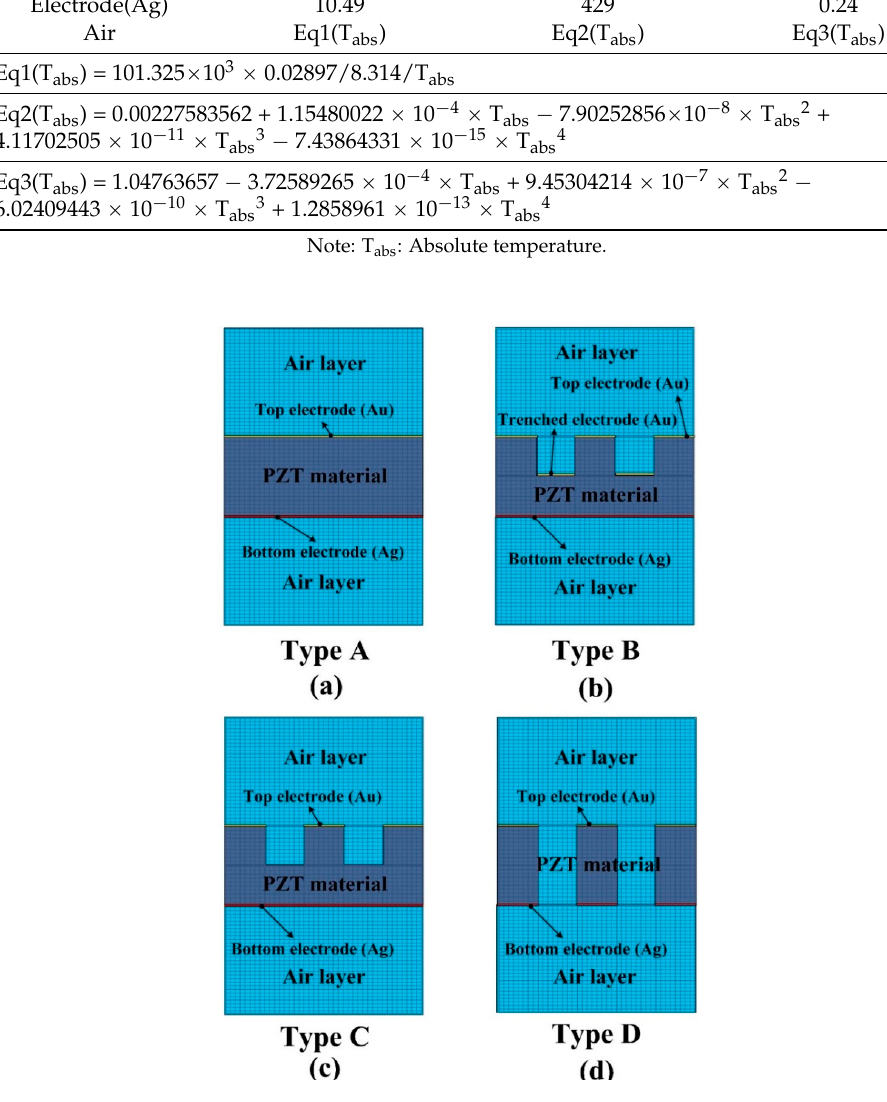
Table 2. Material parameters for finite element analysis.